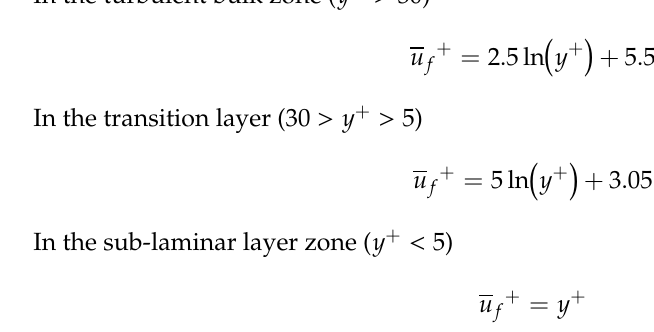
Figure 2. Schematic representation of the three zones of the fluid flow in the pipe and inclusion trajectories.